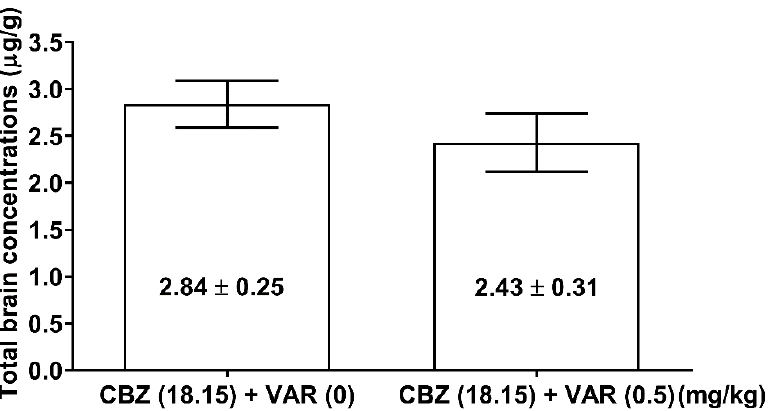
Figure 1. Effect of varenicline (VAR) on total brain concentrations of carbamazepine (CBZ) in mice. Total brain concentrations of CBZ as means (± S.E.M.) of 8 determinants were assayed with fluorescence polarization immunoassay (FPIA) and expressed in µg/g of wet brain tissue.